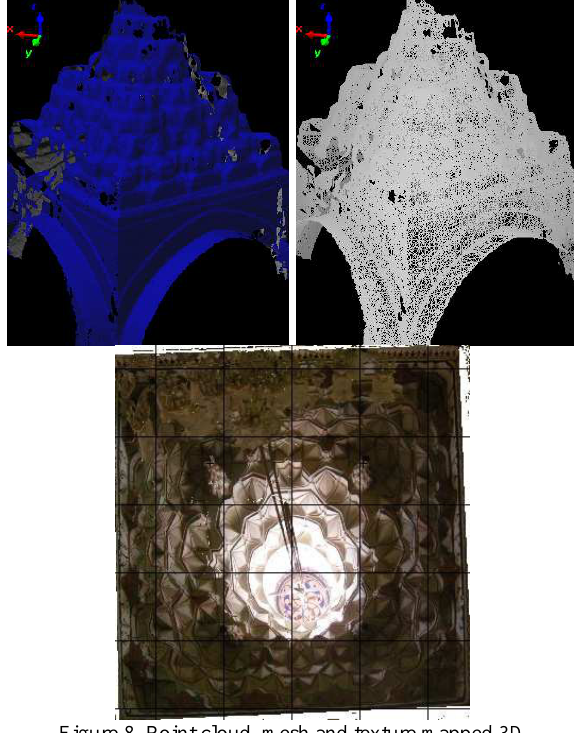
Figure 8. Point cloud, mesh and texture mapped 3D visualization of dome of Silver Sill.